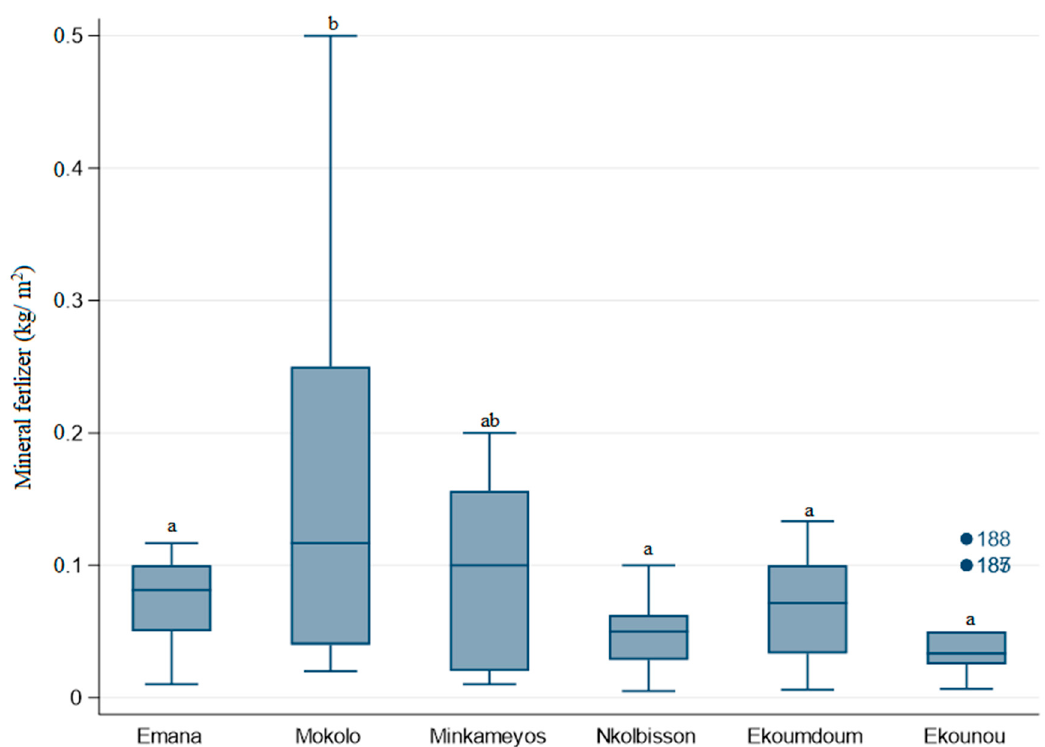
Figure 6. Box plot showing the distribution of the amount of mineral fertilizer used per m 2 in the study sites (same letters indicate no significant differences at p < 0.05; data are shown using box whisker plot to reveal the heteroscedasticity; the significance indicator refers to a robust generalized linear model).